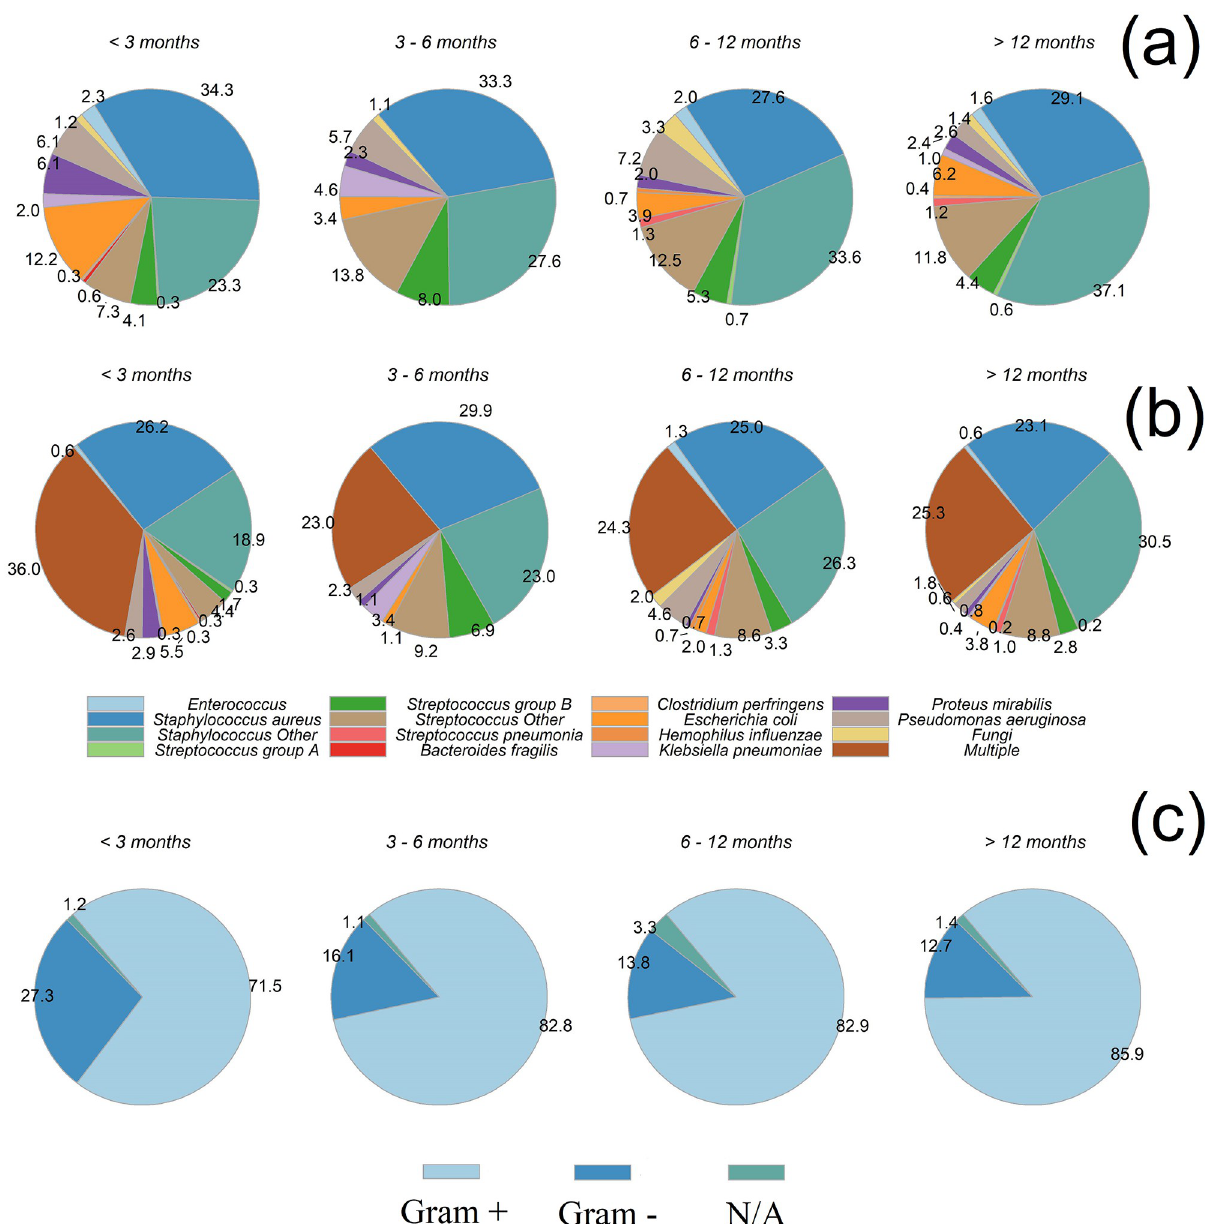
Fig 5. Causative micro-organisms of PJIs observed after different periods of time following arthroplasty aggregated by individual species (a), mono and multi species (b) and Gram (c).